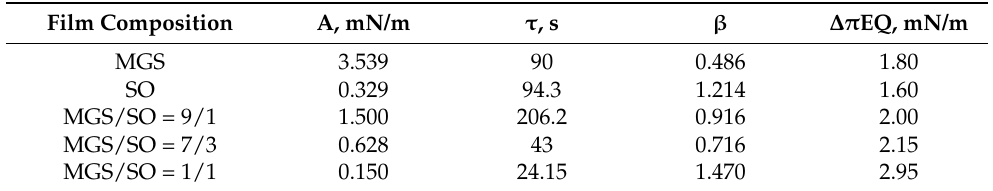
Table 1. Kohlrausch–Williams–Watts (KWW) equation parameters obtained from the fits of the stress relaxation transients (Figure 6, Left panel). For all the fits the adjusted R 2 ≥ 0.98. Film Composition A, mN/m τ , s β